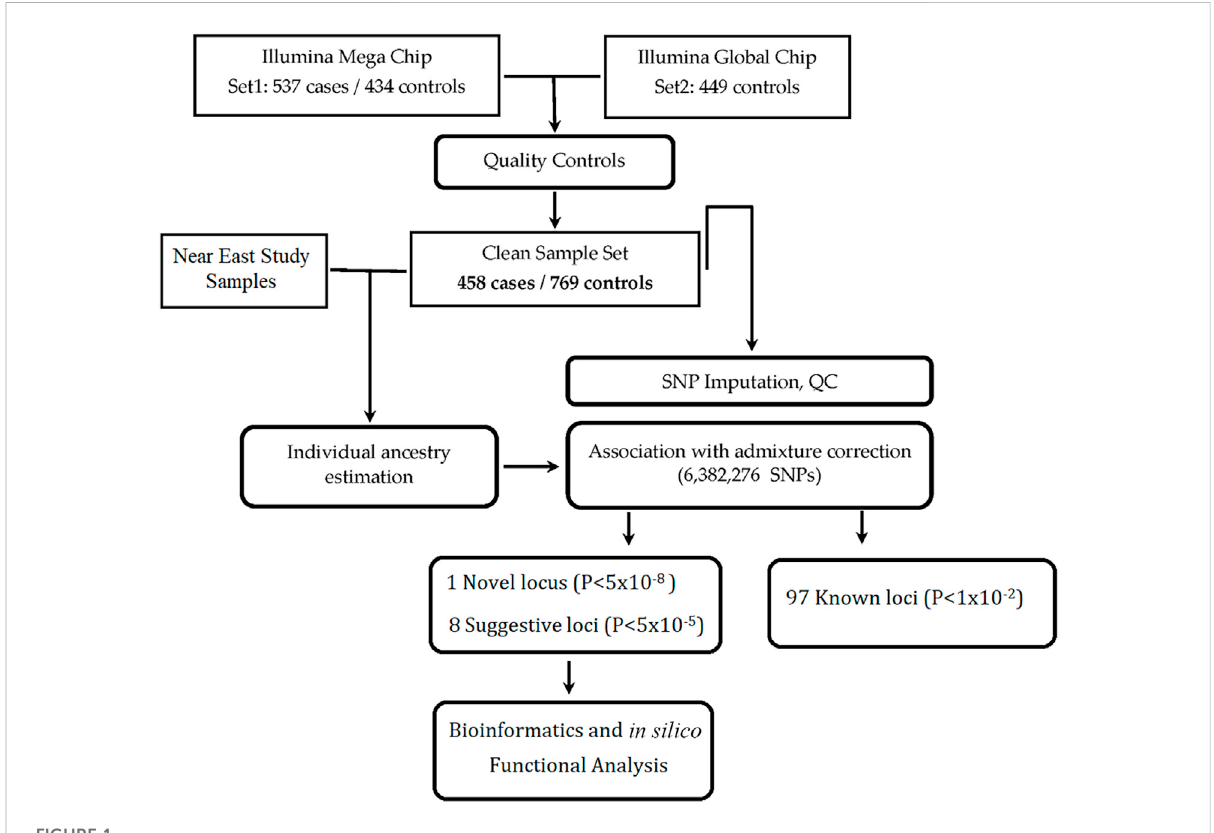
FIGURE 1 Overview and study